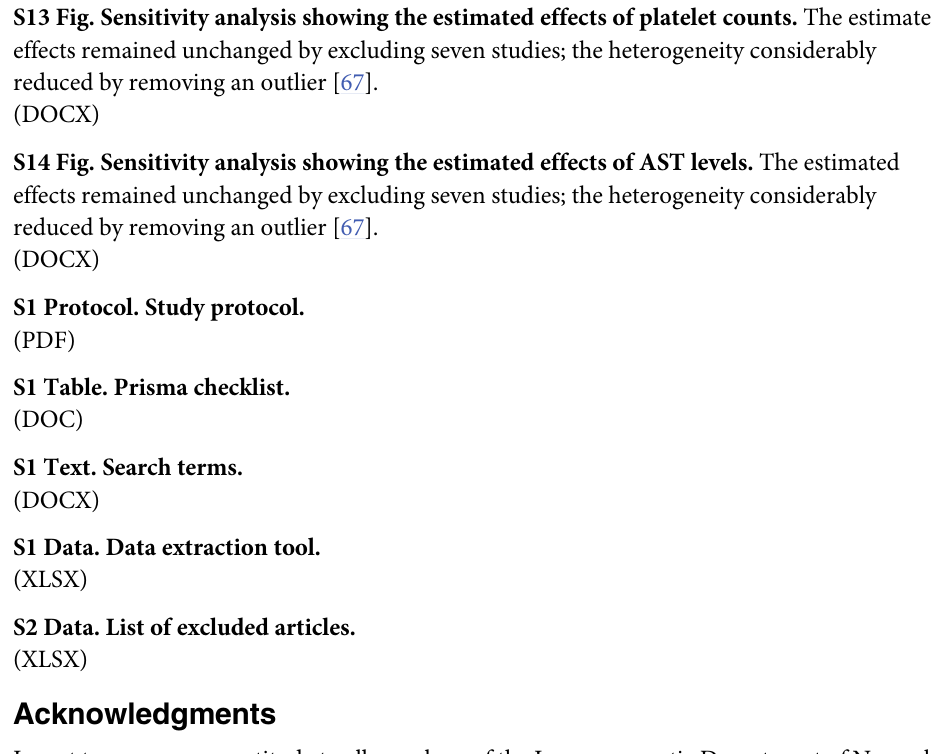
S9 Fig. Forest plot showing the relationship between TNF- α levels and severe dengue. The red dashed line represented the overall effect size. S10 Fig. Forest plot showing the relationship between IL-10 levels and severe dengue. The red dashed line represented the overall effect size. S11 Fig. Forest plot showing the relationship between IFN- γ levels and severe dengue. The red dashed line represented the overall effect size. S12 Fig. Forest plot showing the relationship between viral load and severe dengue. The red dashed line represented the overall effect size. S13 Fig. Sensitivity analysis showing the estimated effects of platelet counts. The estimated effects remained unchanged by excluding seven studies; the heterogeneity considerably reduced by removing an outlier [67]. S14 Fig. Sensitivity analysis showing the estimated effects of AST levels. The estimated effects remained unchanged by excluding seven studies; the heterogeneity considerably reduced by removing an outlier